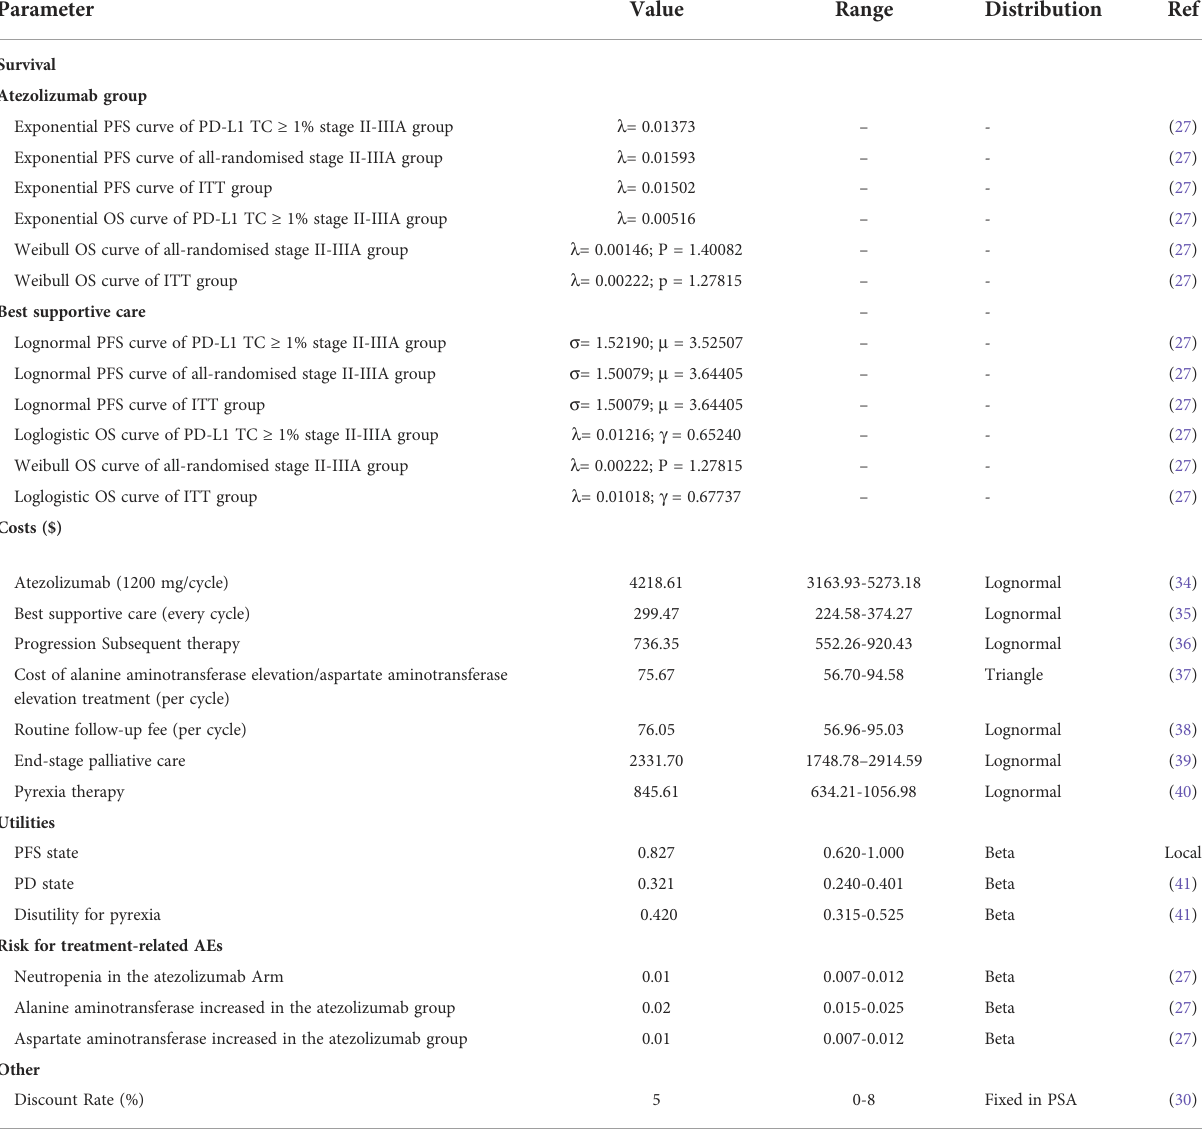
TABLE 1 Model parameters: baseline values, ranges, and distributions for sensitivity analysis. Parameter Value